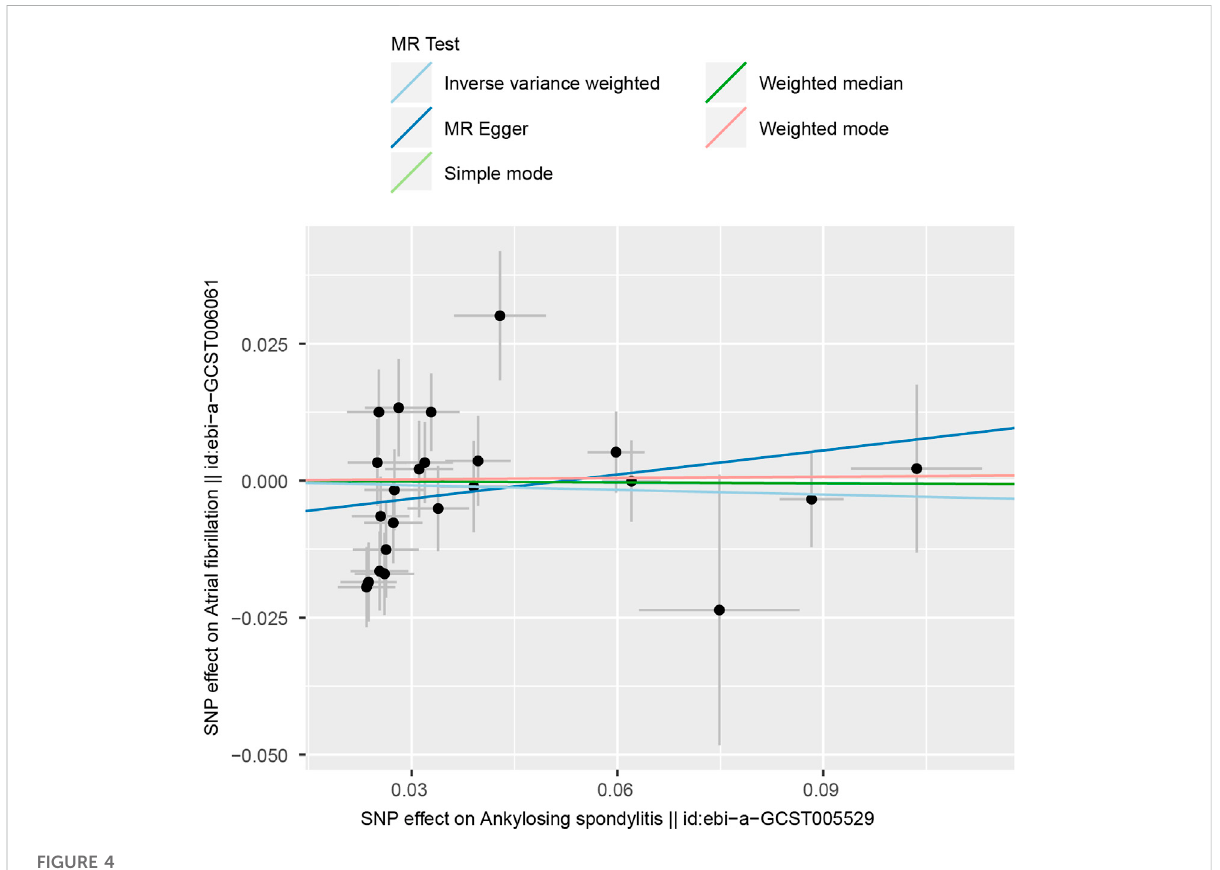
FIGURE 4 The scatter plot of fi ve Mendelian randomization